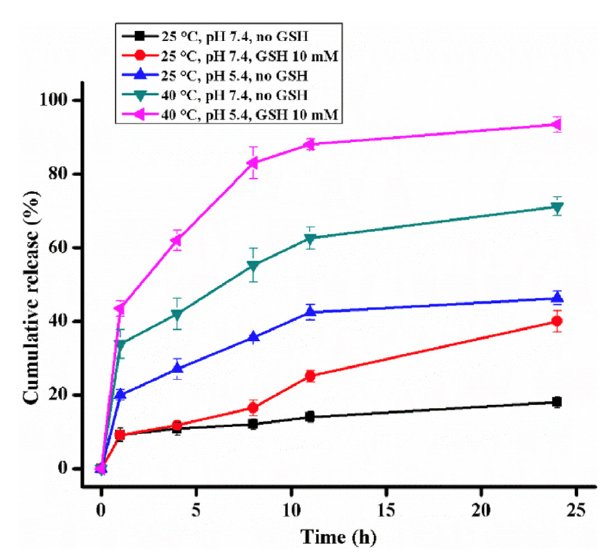
Figure 14. The cumulative release of doxorubicin under different conditions [105]. Reprinted from Reactive and Functional Polymers, 154, P. Poddar et al., Synthesis of a New Triple-Responsive Biocompatible Block Copolymer: Self-Assembled Nanoparticles as Potent Anticancer Drug Delivery Vehicle, 104679, Copyright (2020), with permission from Elsevier.